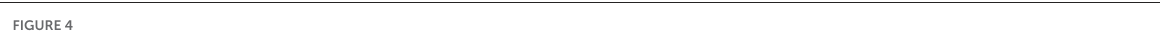
FIGURE4 two-way ANOVA. n = 5. (D–I) Pathological and immunohistochemical sections of tumors were derived from CHMp (upper panels) and CHMp-Luc-EGFP (lower panels). The circled area showed skin invasion. (D,G) Magnification × 10; scale bar, 200 µ m. (E–I) Magnification × 40; scale bar, 50 µ m. (J,K) Immunohistochemical sections of tumors were derived from CHMp cells (left) and CHMp-Luc-EGFP cells (right). Positive cells were indicated with arrows. Magnification × 40; scale bar, 50 µ m. (L) Percentage of Ki-67-positive CHMp cells and Ki-67-positive CHMp-Luc-EGFP cells was 15.31% ± 2.45% and 16.89% ± 2.05%, respectively. Data are the mean of three regions and are presented as the mean ± SD. Significance was determined using a two-tailed unpaired t -test; ns,